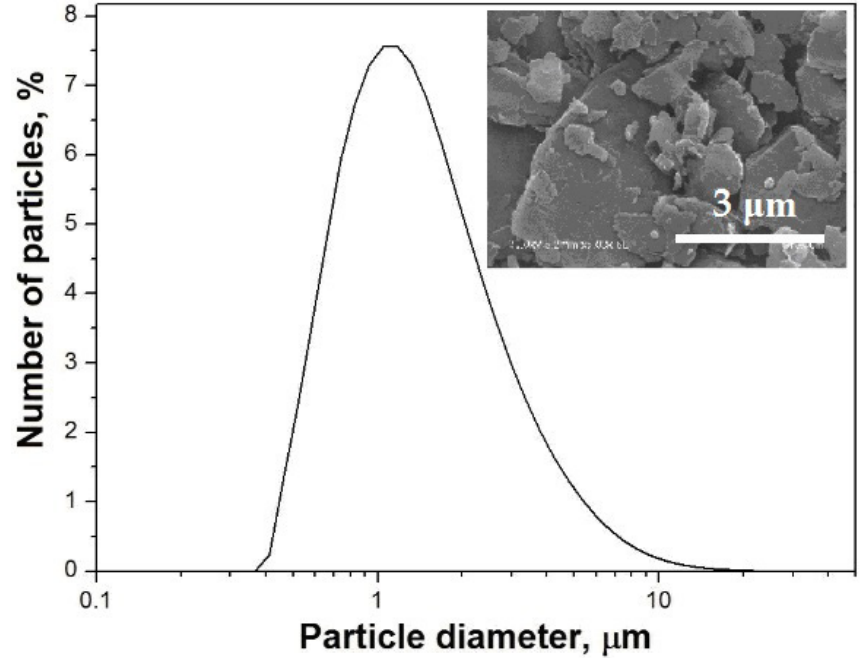
Figure 10. Particle size distribution for graphite and its image (insert).